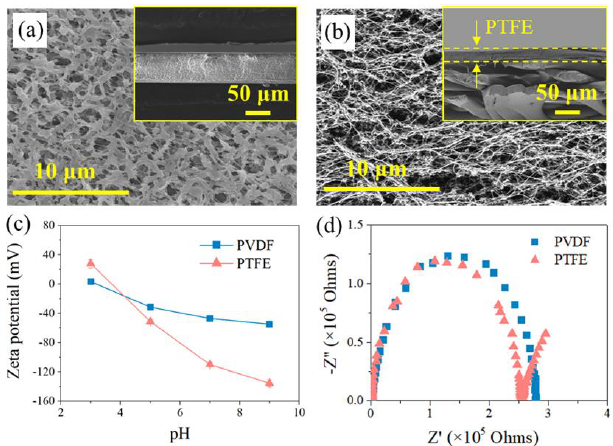
Figure 2. SEM images for membrane morphology of ( a ) PVDF and ( b ) PTFE, with the image for the membrane cross-section inserted. ( c ) Zeta potential of the pristine membranes at different pH values. ( d ) EIS data of the pristine membranes in electrolyte (1 M NaCl solution).